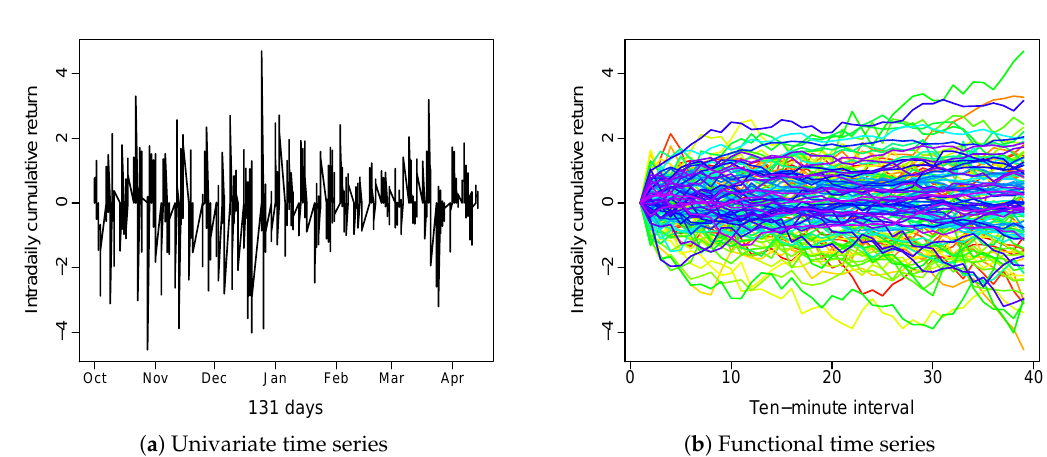
Figure 1. Univariate and functional time series of intraday cumulative returns of AAPL. The univariate time series is the intraday cumulative return of APPL over 131 days, and the functional time series is the intraday cumulative return of APPL based on data of these 131 days, sliced into 10-min intervals. In the rainbow plot, the curves from older times are in red and the more recent curves are in purple.